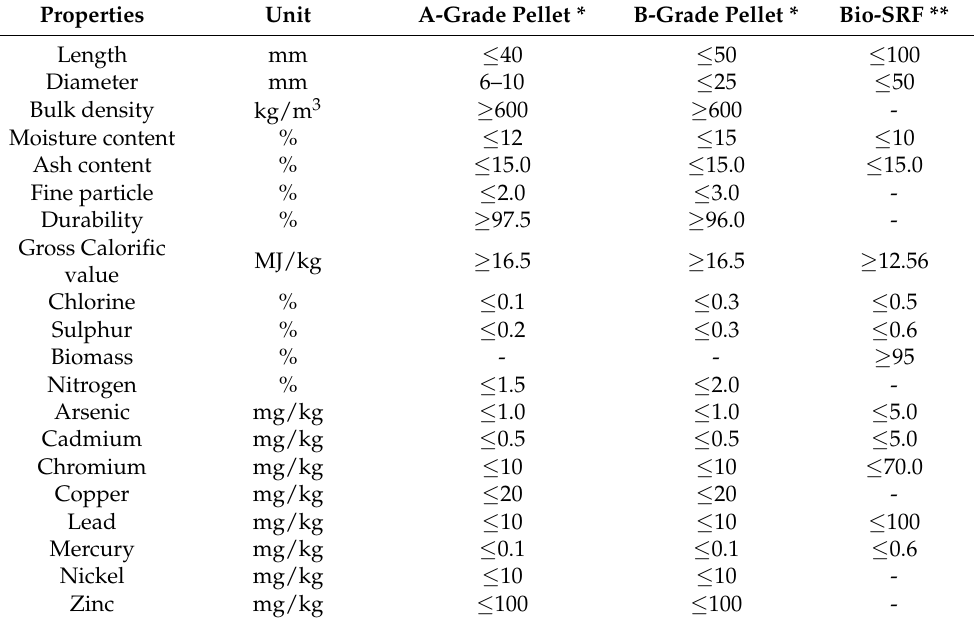
Table 4. Standards for A-grade and B-grade pellets and